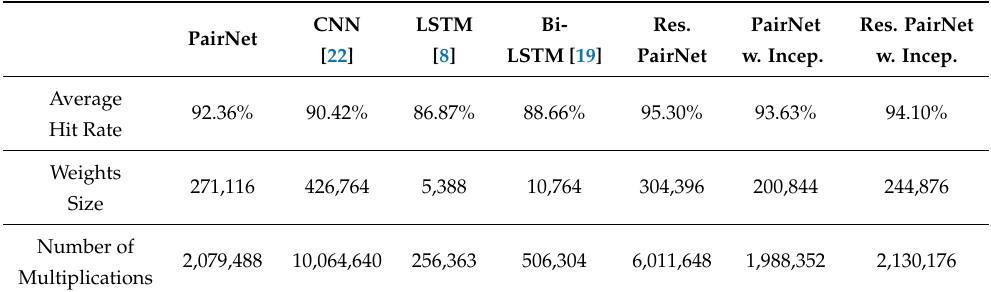
Table 7. The comparisons on average hit rates, number of weights, and computation complexity of various neural networks. The computation complexity of a neural network is the total number of multiplications required for the inference operations of the neural